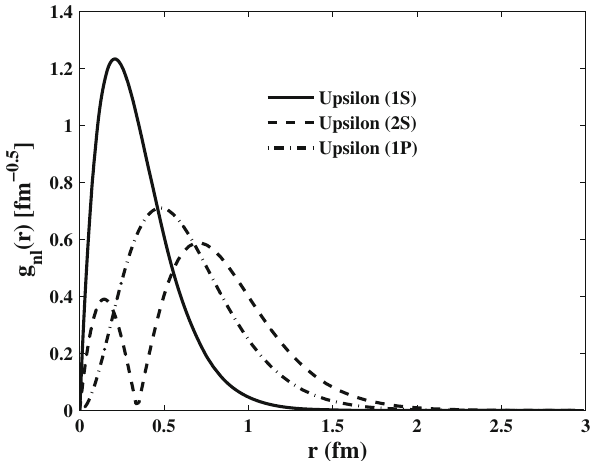
Fig. 4 The variation of radial part of wavefunction of different bot- tomonia states with respect to r . Solid curve represents the 1 S (ϒ) , dashed curve is for 2 S (ϒ) and dash-dotted curve represents the radial wavefunction of 1 P (χ b ) state